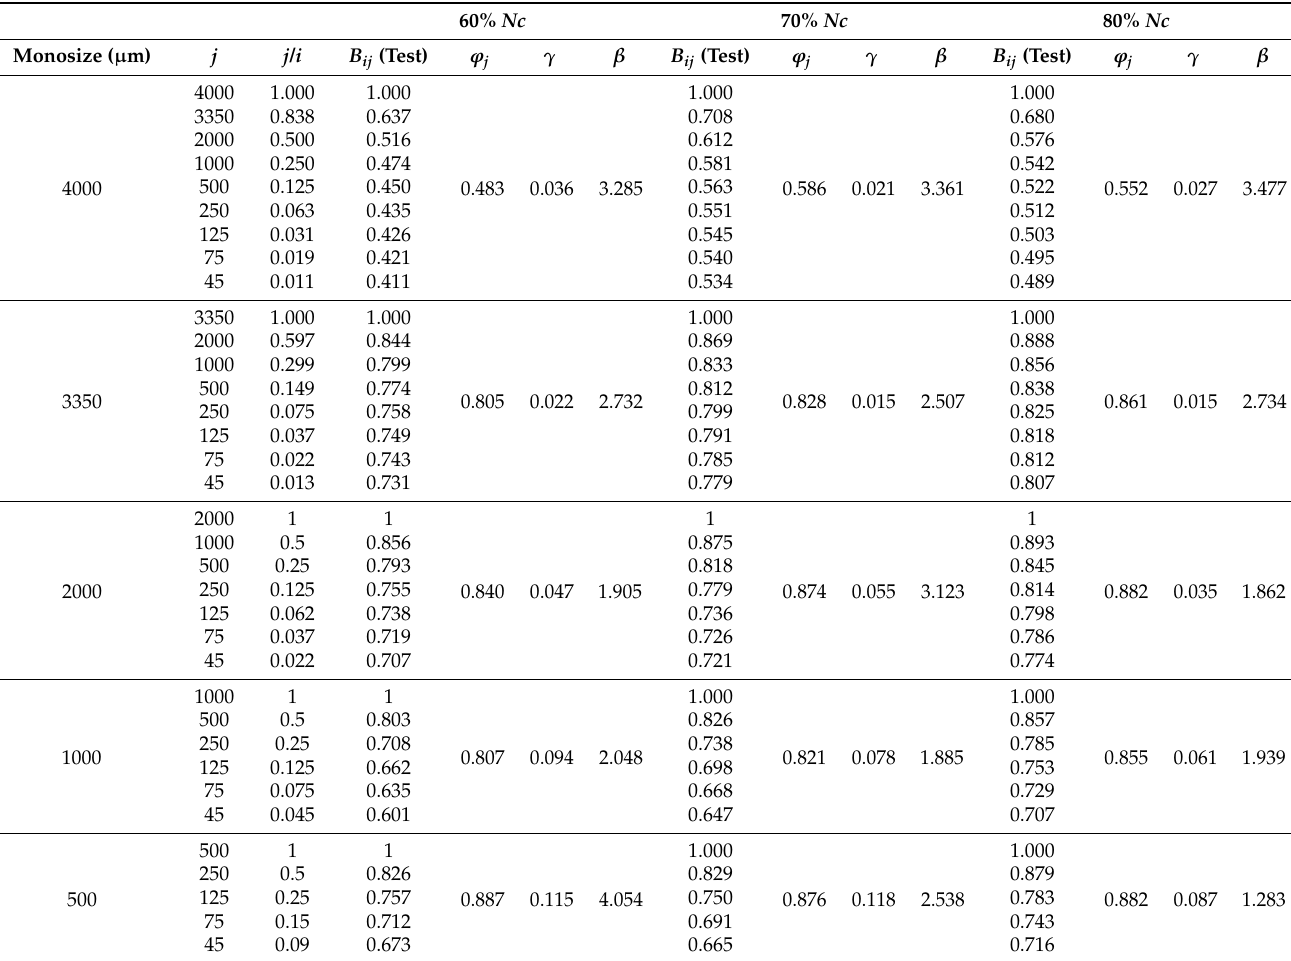
Table 5. Values of the kinetic parameters ( ϕ j , γ , β ) for each monosize and for different mill speed